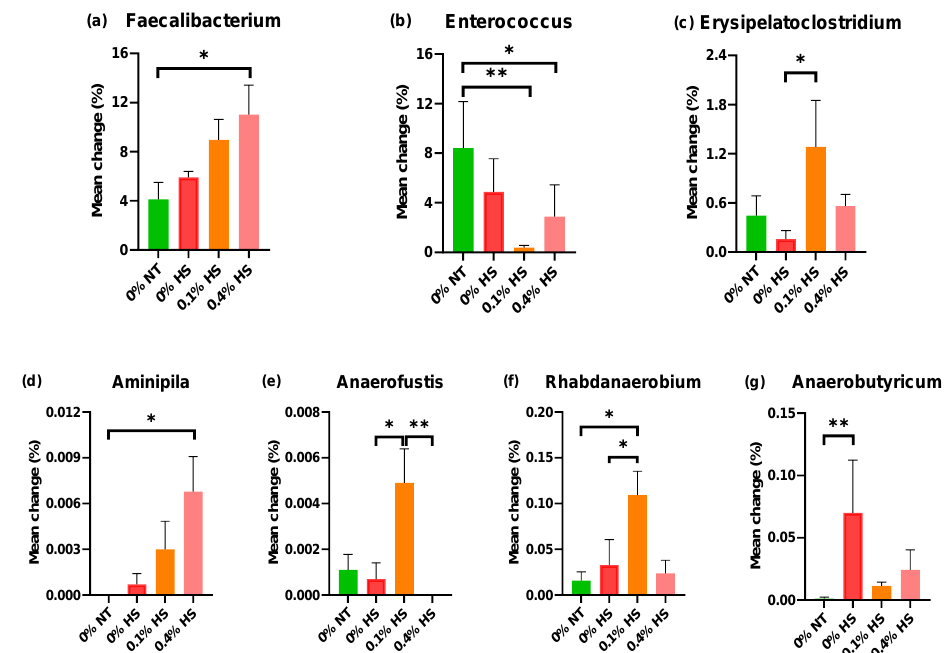
Figure 7. Effects of supplementing diets with solubles from shredded, steam-exploded pine particles (SSPPs) on the significantly modified genera Faecalibacterium , ( a ) Enterococcus , ( b ) Erysipelatoclostridium , ( c ) Aminipila , ( d ) Anaerofustis , ( e ) Rhabdanaerobium , ( f ) and Anaerobutyricum ( g ) in the ceca of broiler chickens exposed to either thermoneutral or heat-stress conditions. Chickens were fed with diets containing 0% (control), 0.1%, and 0.4% SSPPs from the 8th day to the 36th day of age. On the 37th day, birds were either kept at thermoneutral temperature (21.0 °C) and provided a control diet (0% NT) or heat-stressed at 31.0 °C for six hours and provided a diet supplemented with 0% (0% HS), 0.1% (0.1% HS), or 0.4% (0.4% HS) SSPPs. Data show means ± SEM (n = 6). Abbreviations: NT, normal temperature; HS, heat stress. * and **, significant differences at p < 0.1 and p < 0.05, respec- tively.